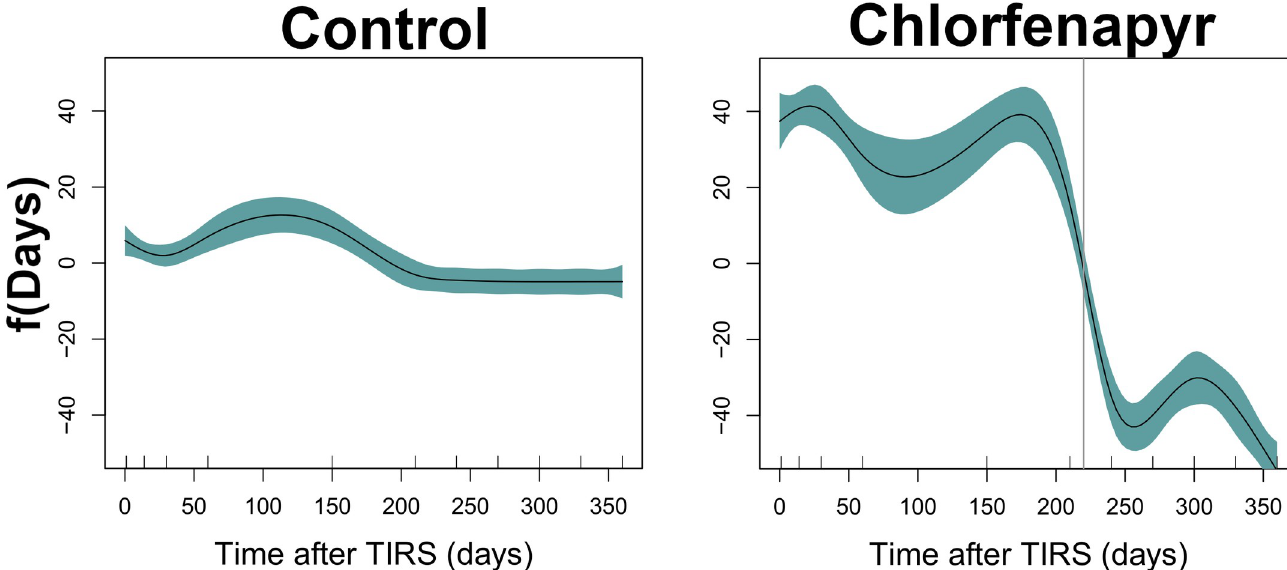
Fig 5. Generalized Additive Linear Mixed Model (GAMM) fitted to the association between mortality [s(Mortality)] and days since TIRS application [f (Days)] for the control and chlorfenapyr houses. The gray vertical line on the right panel shows the threshold of change from positive to negative impact of chlorfenapyr on mosquito mortality.